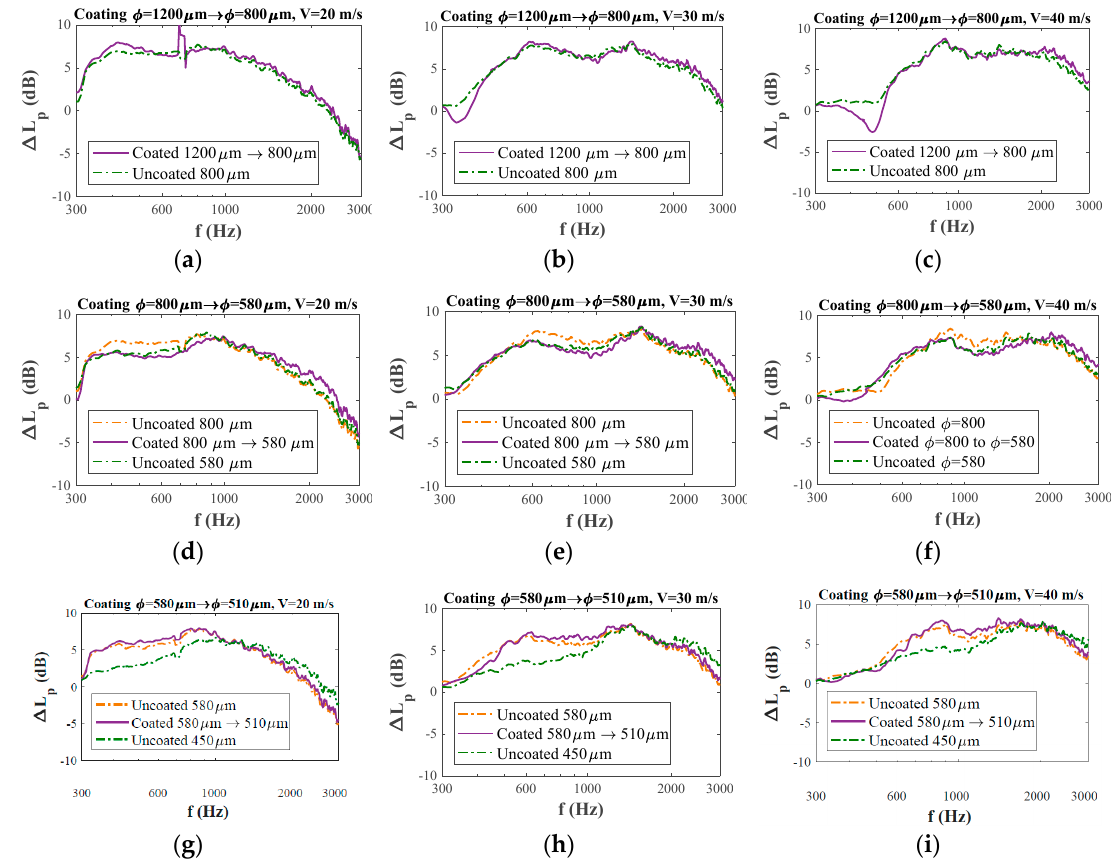
Figure 8. Comparison of noise abatement ∆ L p between coated and uncoated trailing edges at different frequencies f with respect to the solid reference edge for initial pore sizes of ( a ) 1200 µ m in V = 20 m/s, ( b ) 1200 µ m in V = 30 m/s, ( c ) 1200 µ m in V = 40 m/s, ( d ) 800 µ m in V = 20 m/s, ( e ) 800 µ m in V = 30 m/s, ( f )